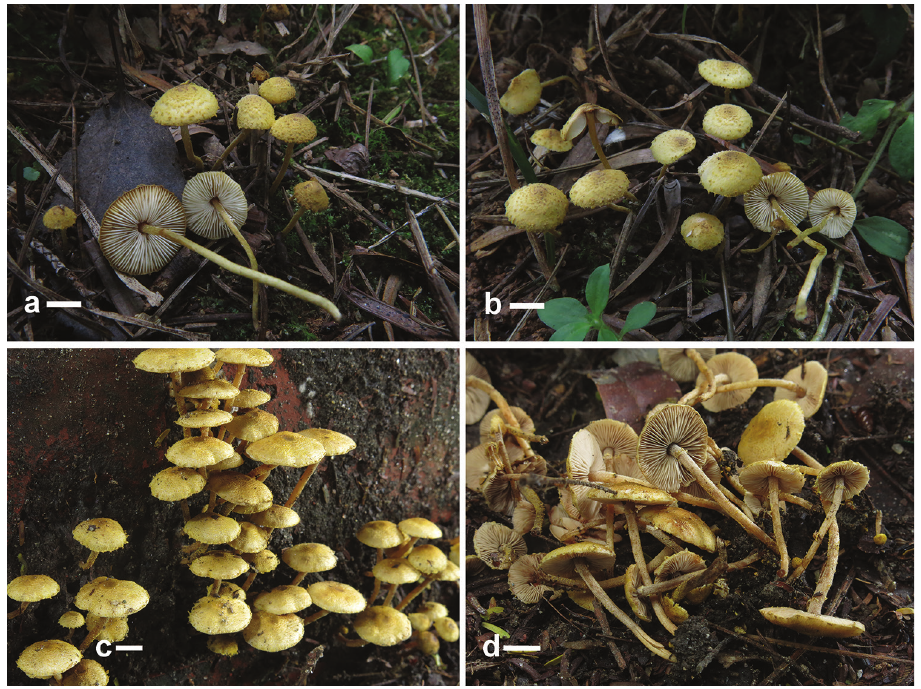
Figure 2. Basidiomata of Xanthagaricus species. a, b Basidiomata of X. flavosquamosus ( a, b GDGM 50918, holotype) c, d Basidiomata of X. necopinatus (GDGM 46632, holotype; PHI-12, isotype). Scale bars: 5